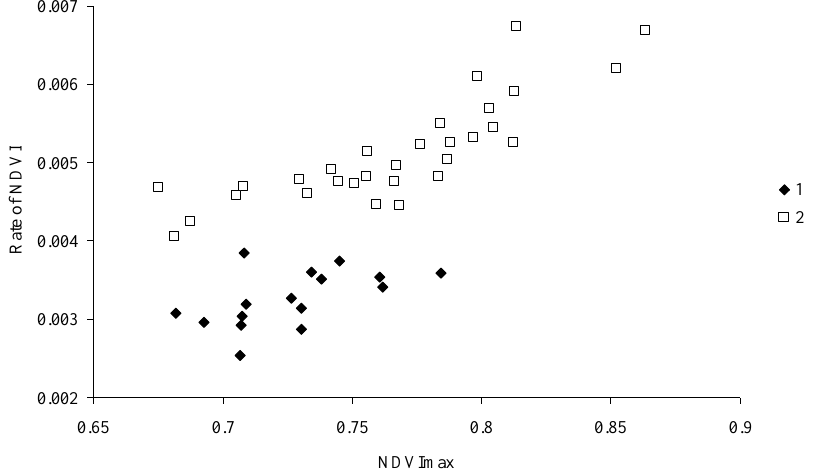
Figure 7. NDVIF max and dNDVIF / dn for 2003–2017 for ( 1 ) coniferous forest; ( 2 ) mixed forest.